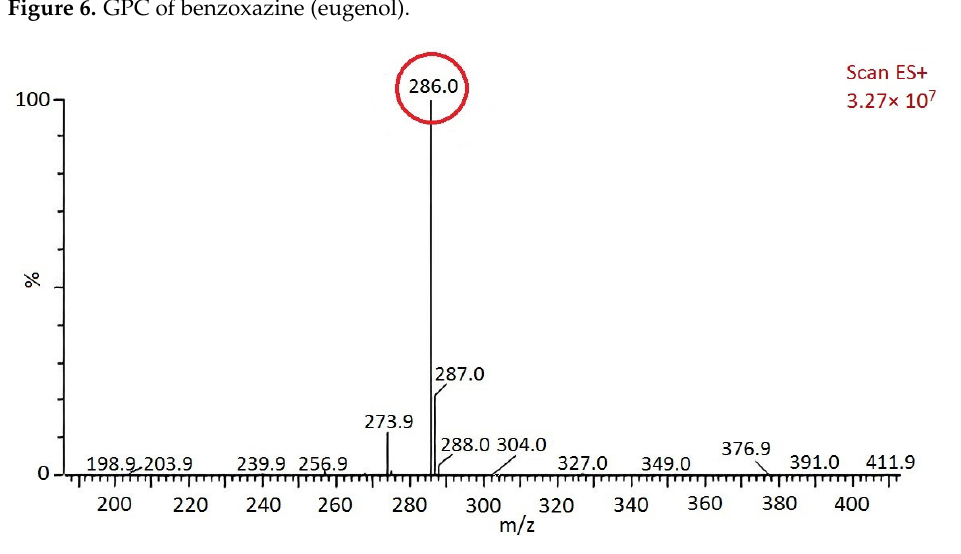
Figure 6. GPC of benzoxazine (eugenol).